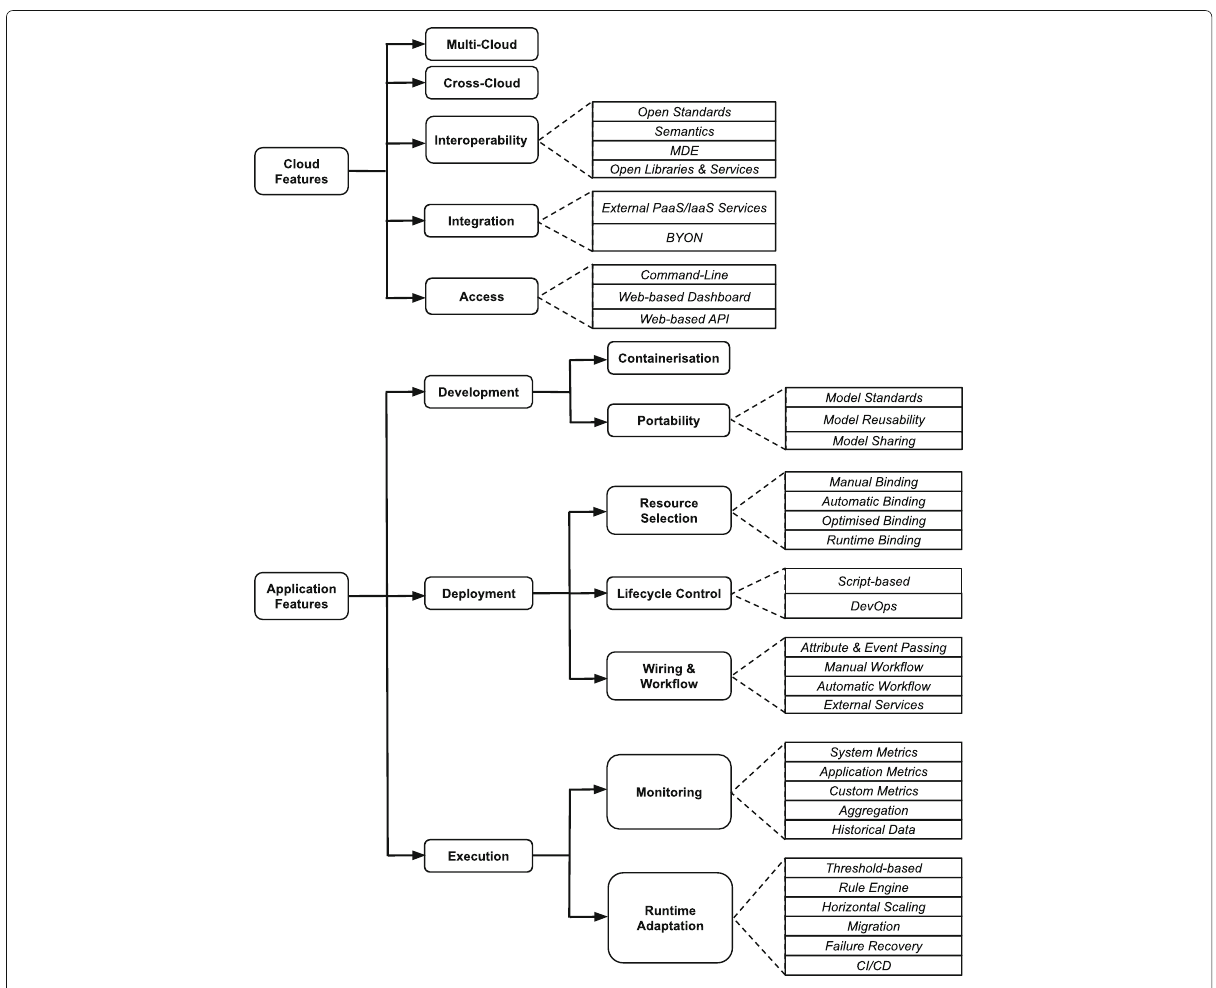
Fig. 4 Taxonomy of the CROF characterisation framework